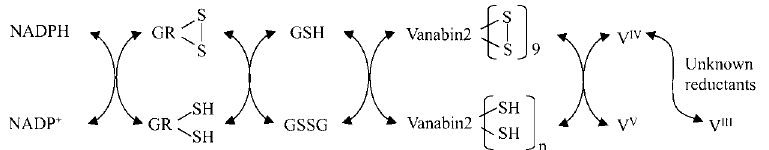
Figure 6 A possible cascade for the thiol-disulfide exchange reactions conjugated with NADPH, GR (glutathione reductase), GSH, Vanabin2, and vanadium ions. Reproduced from Ref. (115). Copyright 2009 Elsevier B.V. the activity of ribonucleotide reductase (120), the mainte- nance of redox potentials (121), responses against oxidative stress caused by metal ions (122), and metal transfer from metalloproteins to metal-depleted enzymes (metallochape- rone activity) (123) in a manner analogous to the phospho- rylation/dephosphorylation reactions catalyzed by protein kinases and